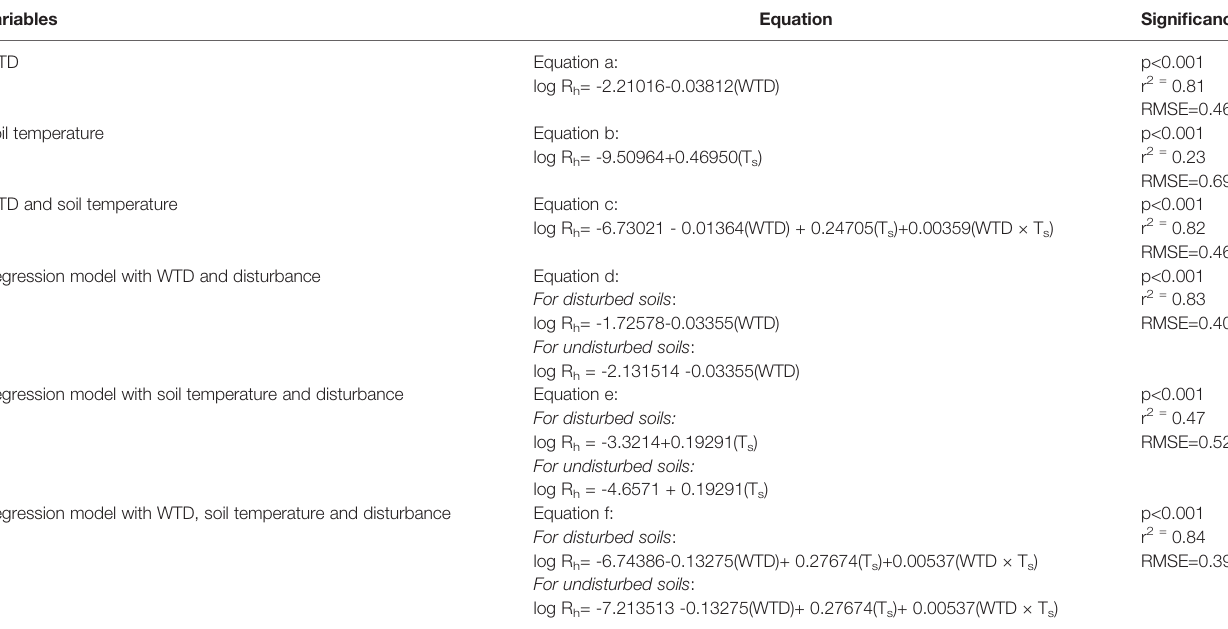
TABLE 5 | Linear models for soil and water table depth, for the regularly sampled morning and afternoon data and for when the data is split based on disturbance (i.e. disturbed data is from raised beds in May and November sampling occasions).